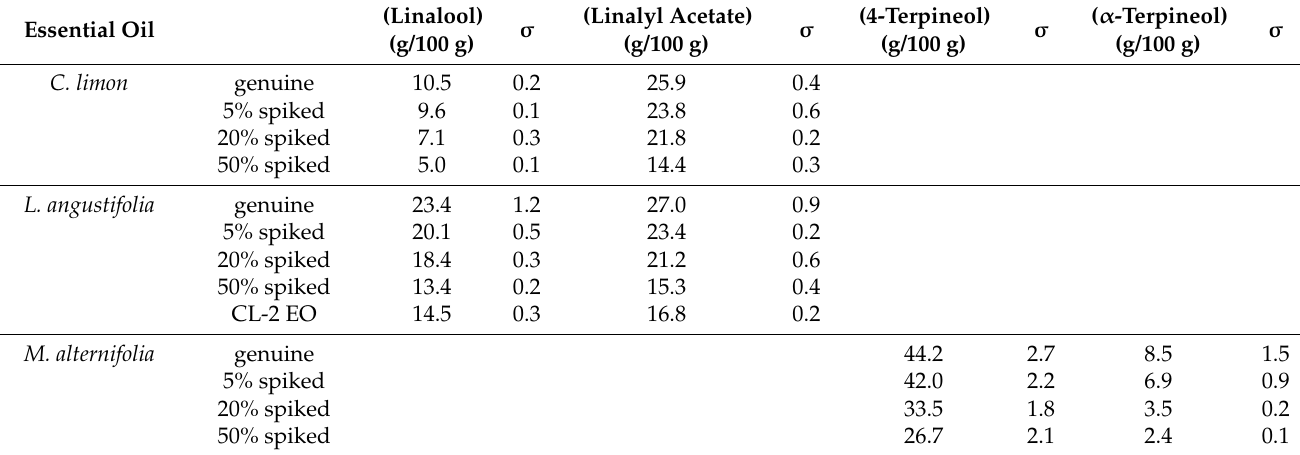
Table 4. Absolute concentrations of the selected marker compounds in the investigated essential oils. Essential Oil